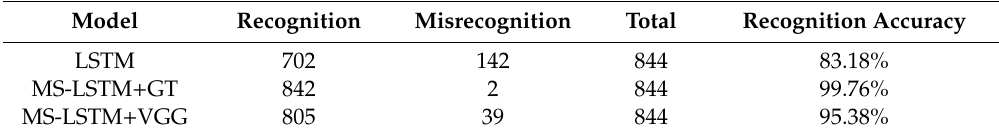
Table 4. Performances of the 3 networks with the validation